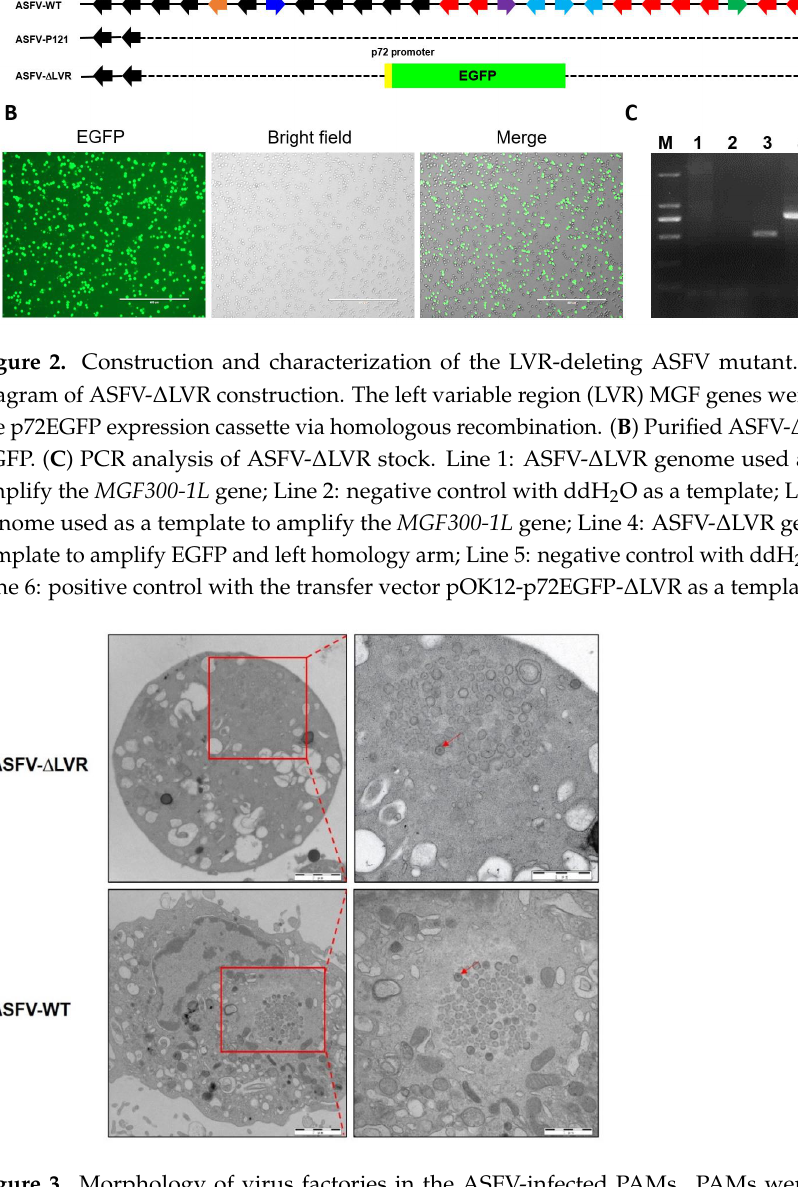
** Figure 4. The viral growth of the LVR-deleted ASFV mutant in PAMs. PAMs were infected with ASFV-WT or ASFV- ∆LVR (MOI = 0.01) , and virus titers yields were determined at the indicated – time points post-infection. The data are presented as the mean ± SD of three independent experi- ments. (* p < 0.05; ** p < 0.01).